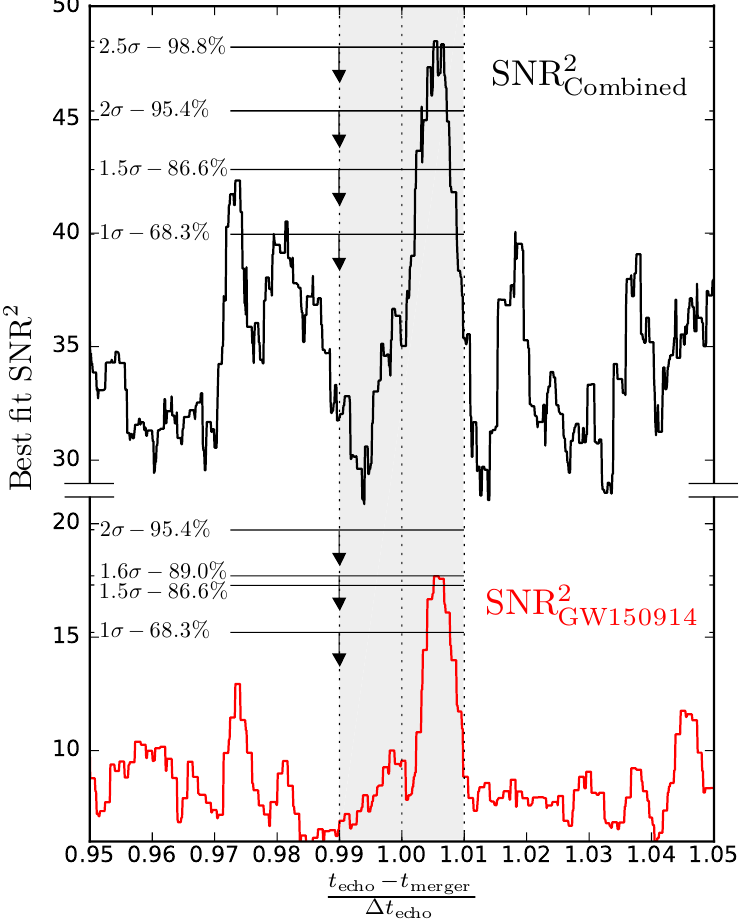
Figure 17. Maximized SNR 2 around the expected time of merger echoes Equation (144), for the combined (top) and GW150914 (bottom) events. The significance and p -values of the peaks within the gray rectangle are specified in this plot